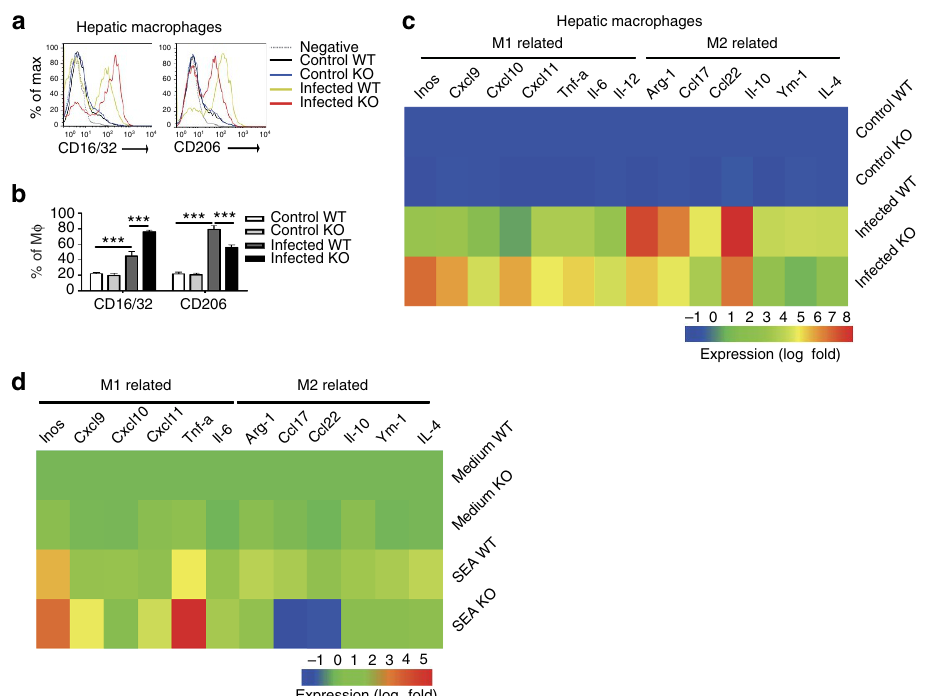
Figure 3 | SR-A deficiency promotes M1 polarization after S. japonicum infection. FACS analysis of proportion of CD16/32 þ or CD206 þ on hepatic macrophages ( a , b ) from WTor SR-A-deficient mice infected with or without S. japonicum . Data are expressed as the mean ± s.d. of 12 mice per group, and are representative of one typical experiment out of three, *** P o 0.001, ** P o 0.01 (ANOVA/LSD). ( c ) Hepatic macrophages were purified by Flow sorting from normal or S. japonicum -infected WTor SR-A-deficient mice at 8 weeks post infection or ( d ) peritoneal macrophages from WTor SR-A-deficient mice were purified and stimulation with SEA. Expression of M1- or M2-related genes was evaluated by real-time PCR. Transcript levels for each gene in macrophages are expressed as fold change over transcript levels in macrophages from control WT mice or WT macrophages treated with medium, respectively. Results are presented as higher (red) or lower (blue) expression after infection or stimulation (key (below), log 2 fold change). Data are from three independent experiments and expressed as the mean of each group from one representative